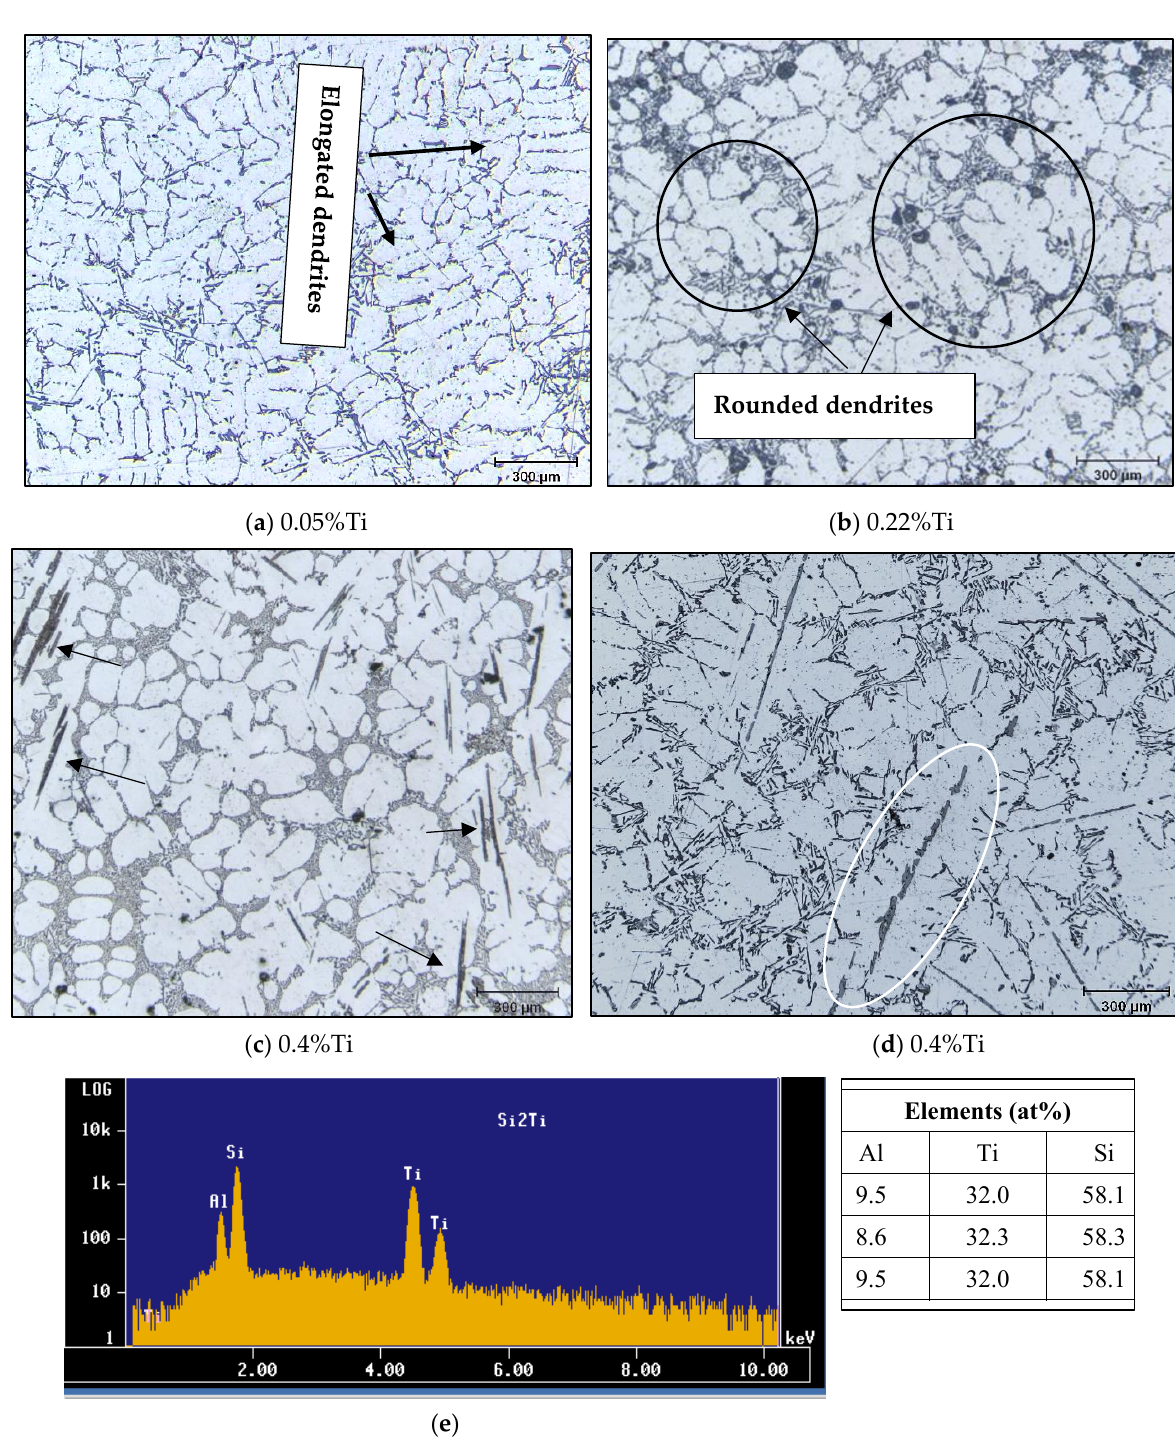
Figure 14. Optical microstructures of A356.2 alloy at different addition of Ti: ( a ) as received alloy (0.05%Ti); ( b ) 0.22%Ti cast from 750 °C (30 min stirring); ( c ) 0.4%Ti with no superheating; ( d ) 0.4%Ti superheating at 950 °C prior to casting from 750 °C; ( e ) EDS corresponding to ( e ) revealing strong peaks of Al, Si, and Ti-inserted table, indicating the actual composition measured at three spots. Black arrows in ( c ) point to (Al,Si) 3 Ti platelets within the α -Al network.